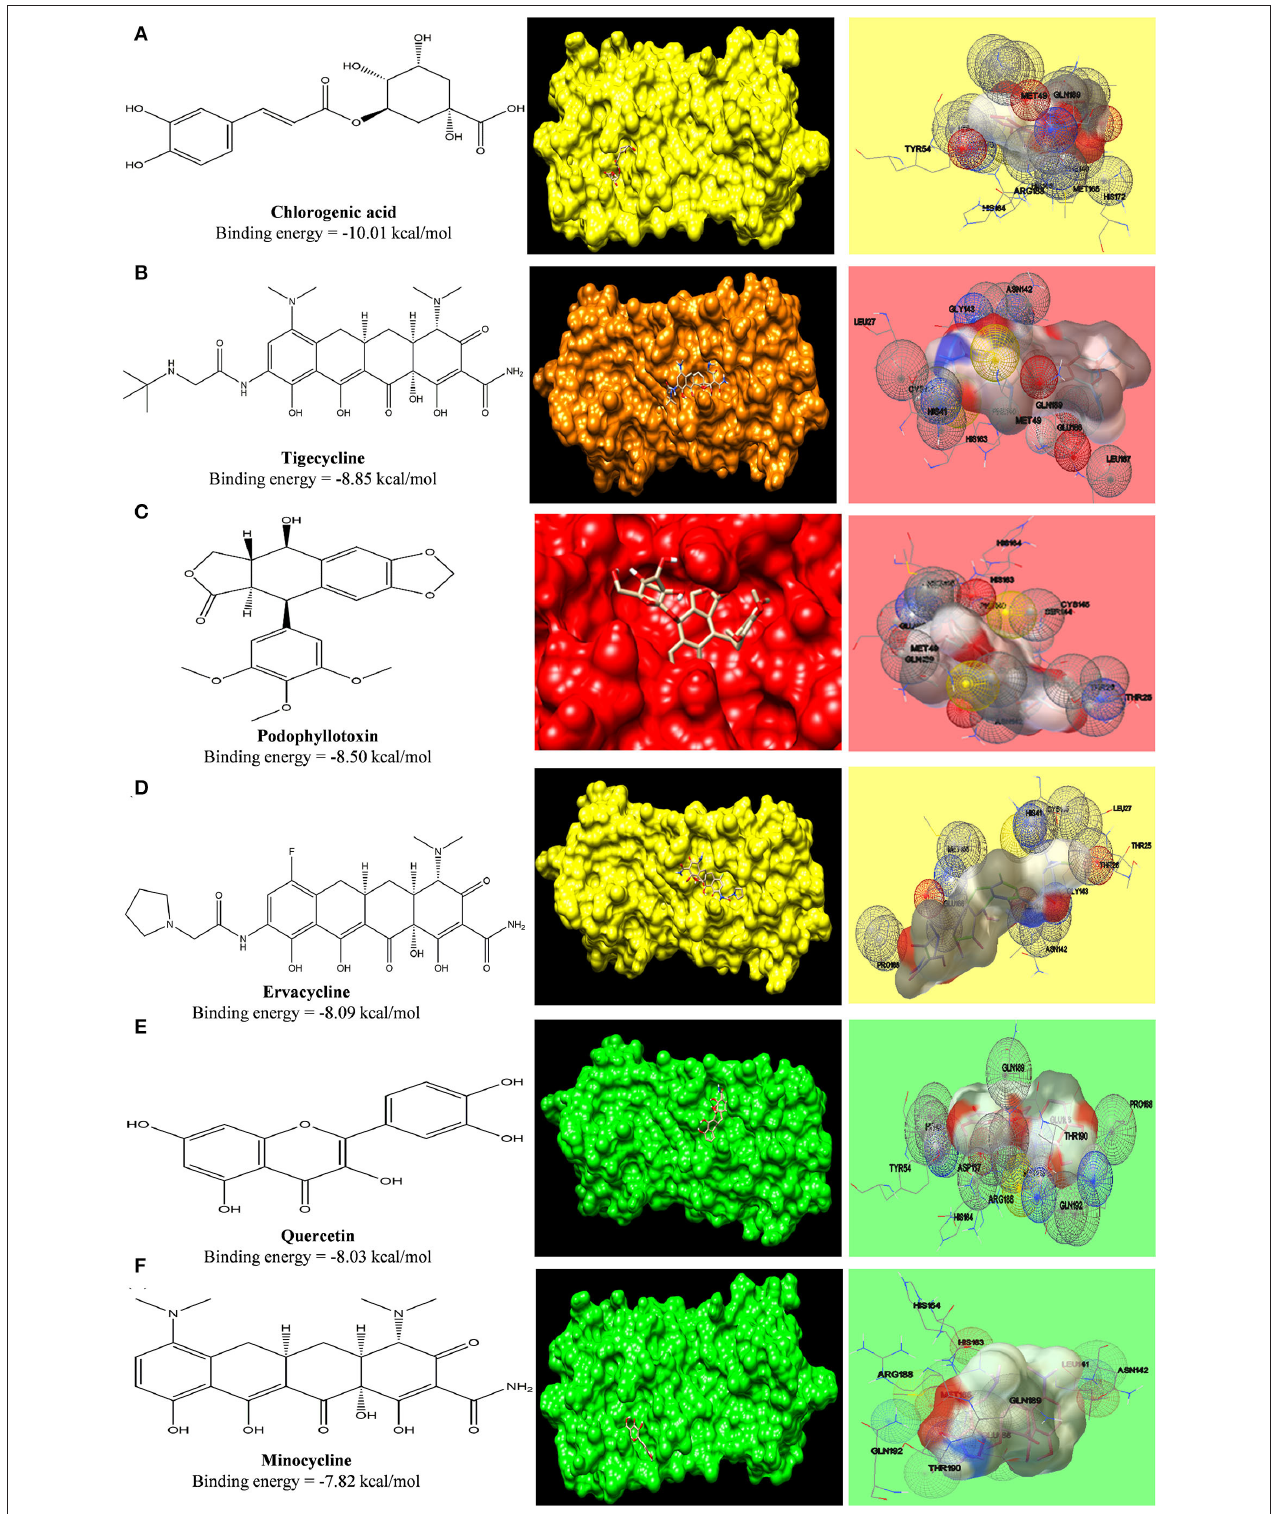
FIGURE 10 | Computed structural comparison and binding features (visualization using UCSF Chimera and AutoDock) of Chlorogenic acid (A) , Tigecycline (B) , Podophyllotoxin (C) , Ervacycline (D) , Quercetin (E) , and Minocycline (F) , with SARS-COV2 main protease. The lower the binding energy, the greater will be the binding